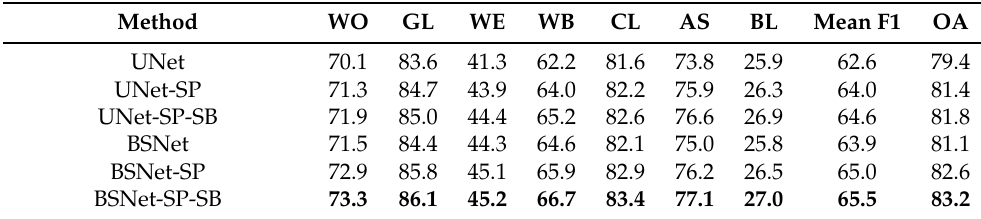
Table 4. The effect of the block shuffle structure, superpixel branch and self-boosting on Landsat extend